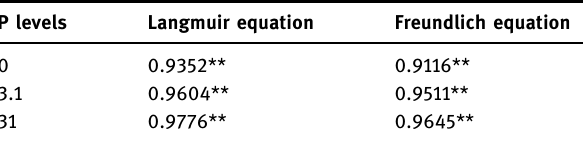
Table 1: Coe ffi cient ( R 2 ) value of the two nonlinear fi t at three